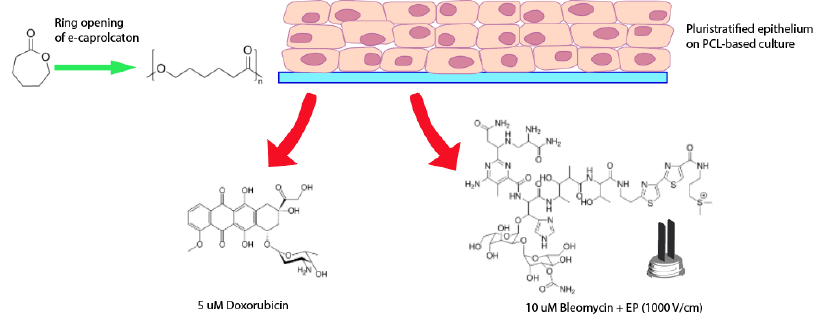
Figure 1. Schematic overview of the experiment set-up.